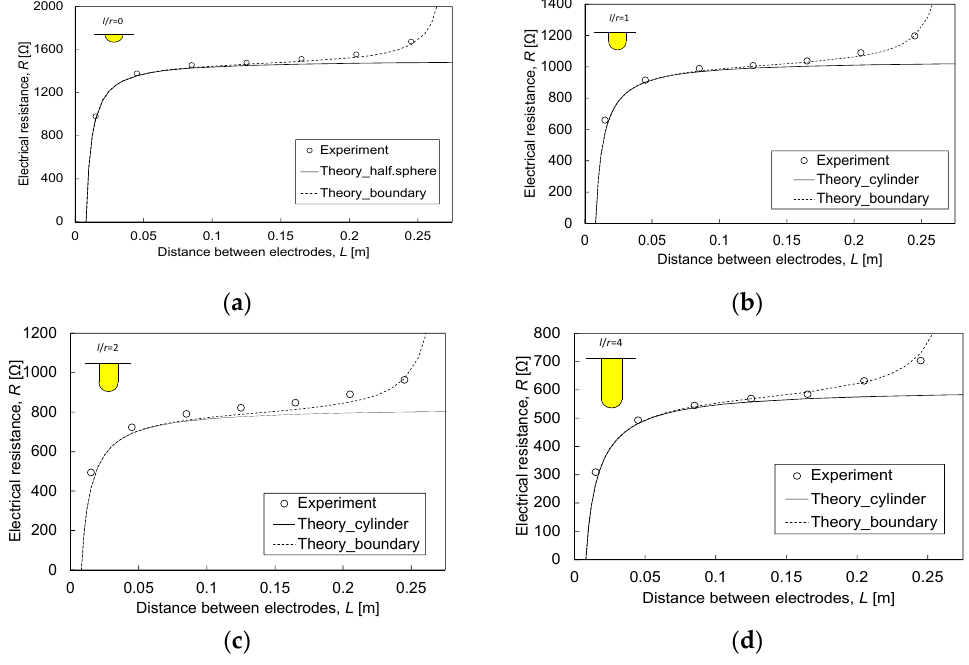
Figure 4. Evolution of electrical resistance with distance and depth (18.88 Ω m): ( a ) l / r = 0, ( b ) l / r = 1, ( c ) l / r = 2, and ( d ) l / r = 4. Continuous lines are obtained from Equation (9) and dashed lines are obtained from Equation (13).